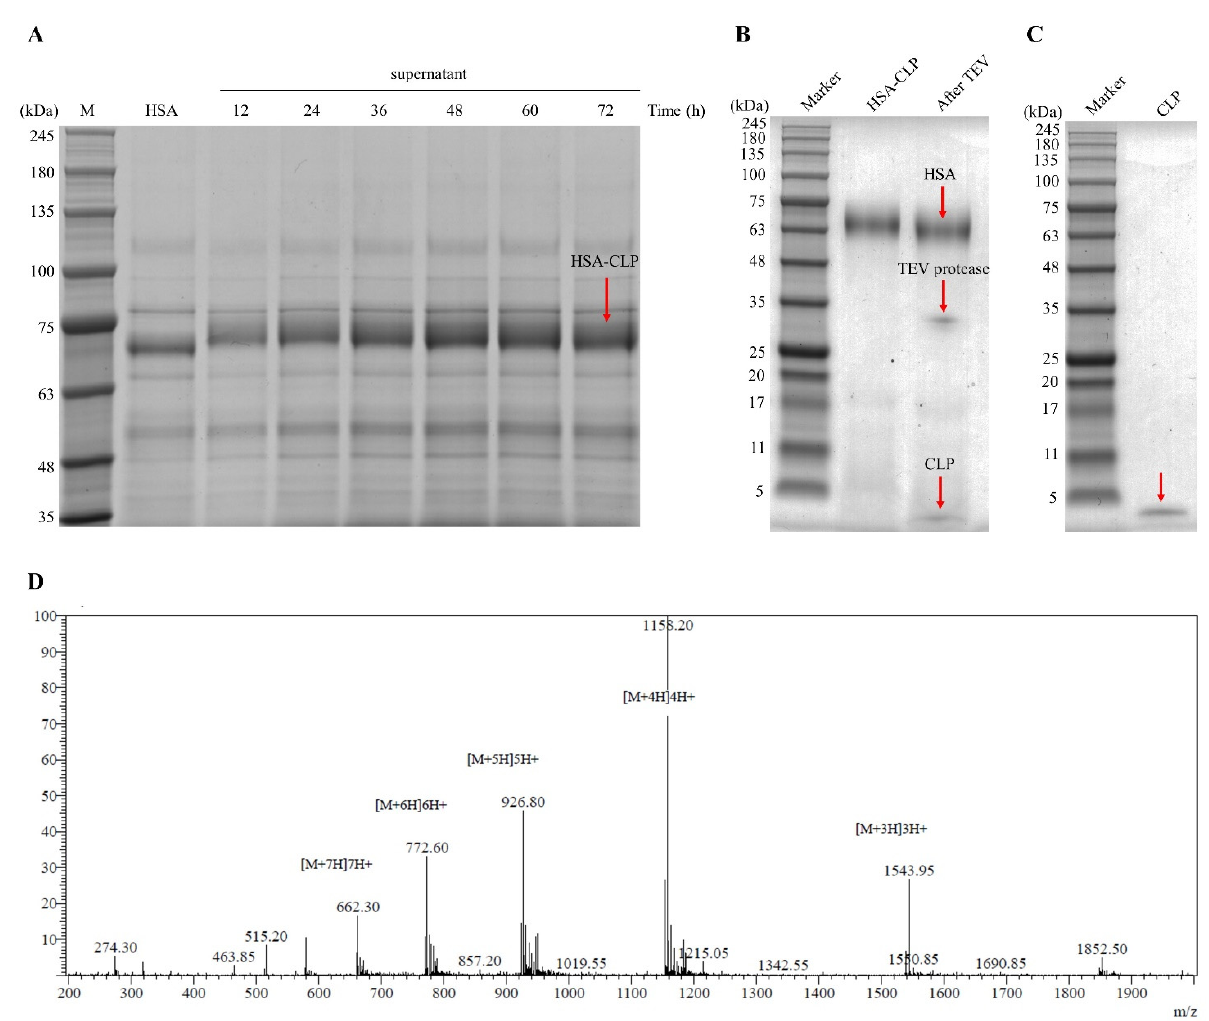
Figure 2. Analysis of recombinant hybrid peptide CLP. ( A ) SDS-PAGE detection of supernatants after methanol induction for 12–72 h (lane M, molecular weight markers; arrow indicates expression of HSA-CLP . ( B ) The purified HSA-CLP and its cleavage products by TEV protease were detected by SDS-PAGE (marker, molecular weight; arrow shows accepted linear epitope and peptides) ( C ) The purified CLP was detected by the SED-PAGE, marker, molecular weight; arrow shows CLP peptide. ( D ) Analysis of hybrid peptide CLP by ESI-MS.